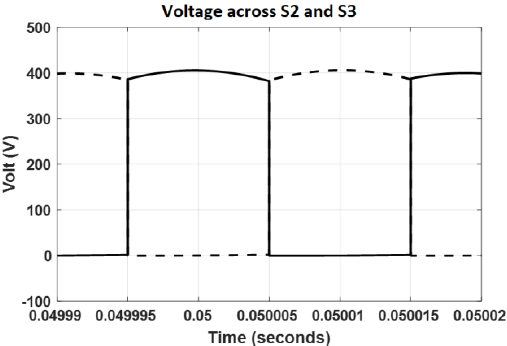
Figure 20. Voltage waveforms across the switches 𝑆 2 and 𝑆 3 in the proposed QZS converter.